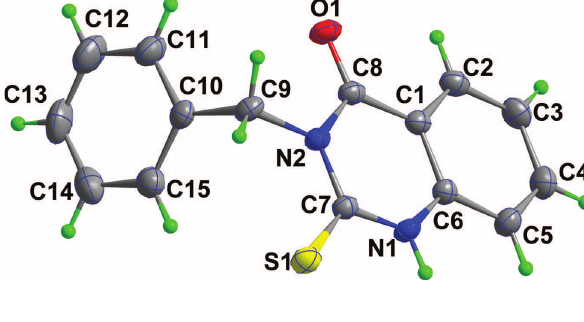
Table 1: Data collection and handling.